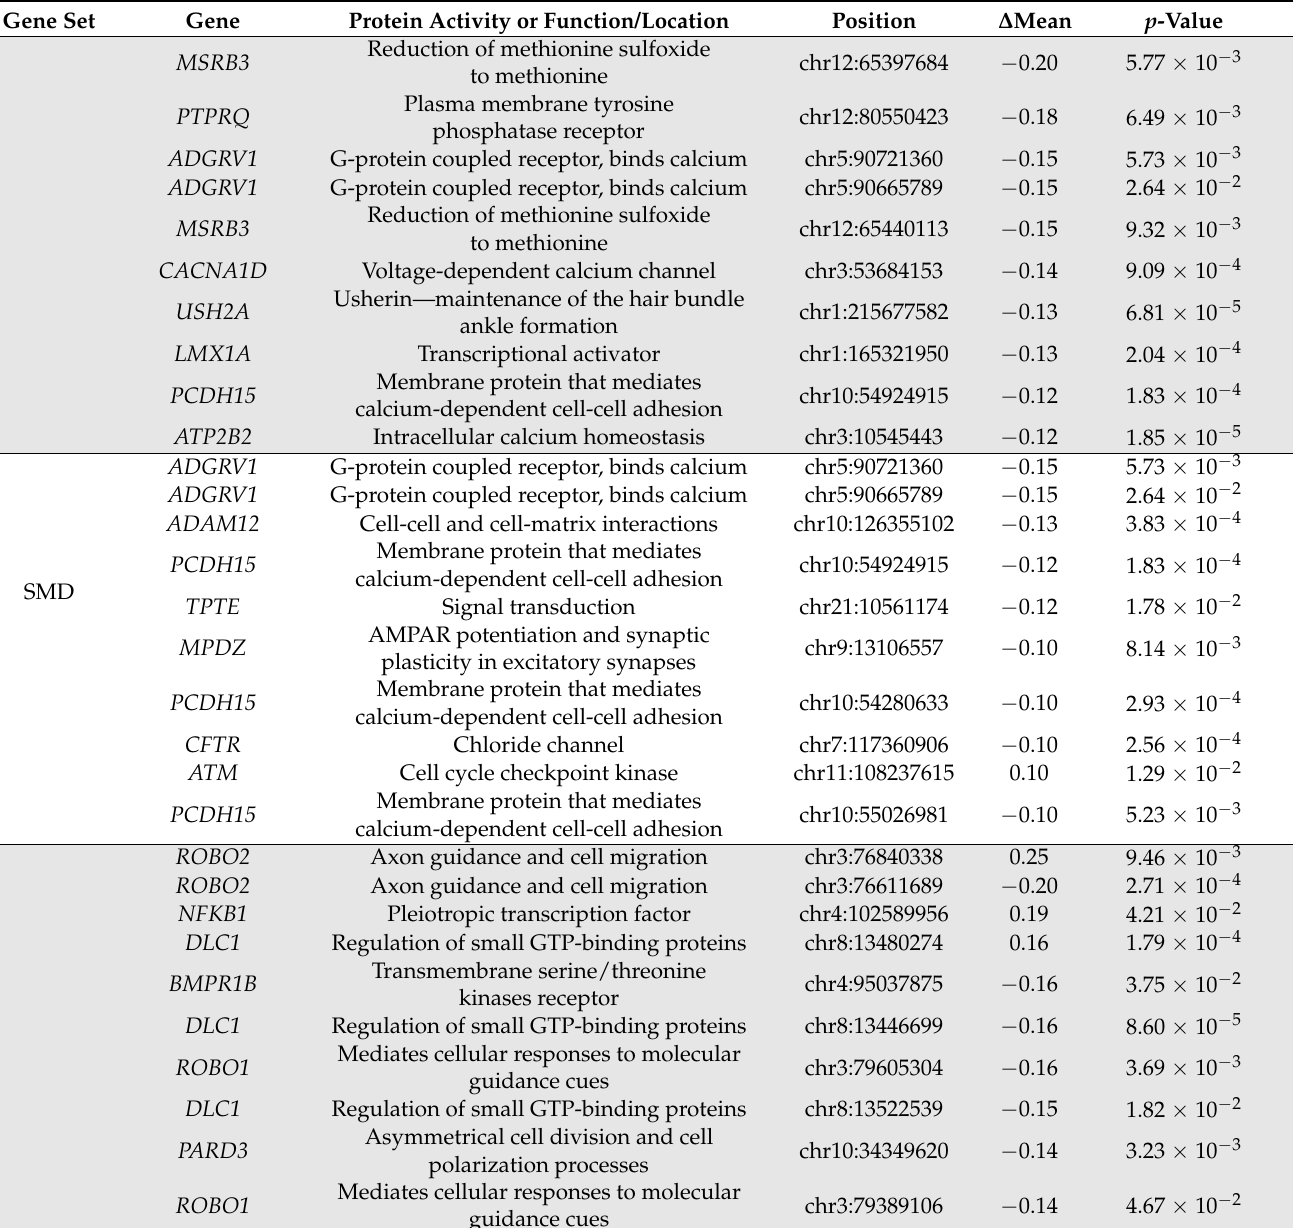
Table 2. Top 10 DMCs ranked according to ∆ Mean value found in hearing loss (HL), sporadic Meniere disease (SMD) and stria vascularis (SV) gene sets when comparing MD patients to controls. p -value is adjusted by FDR. ∆ Mean—difference in methylation between MD patients and